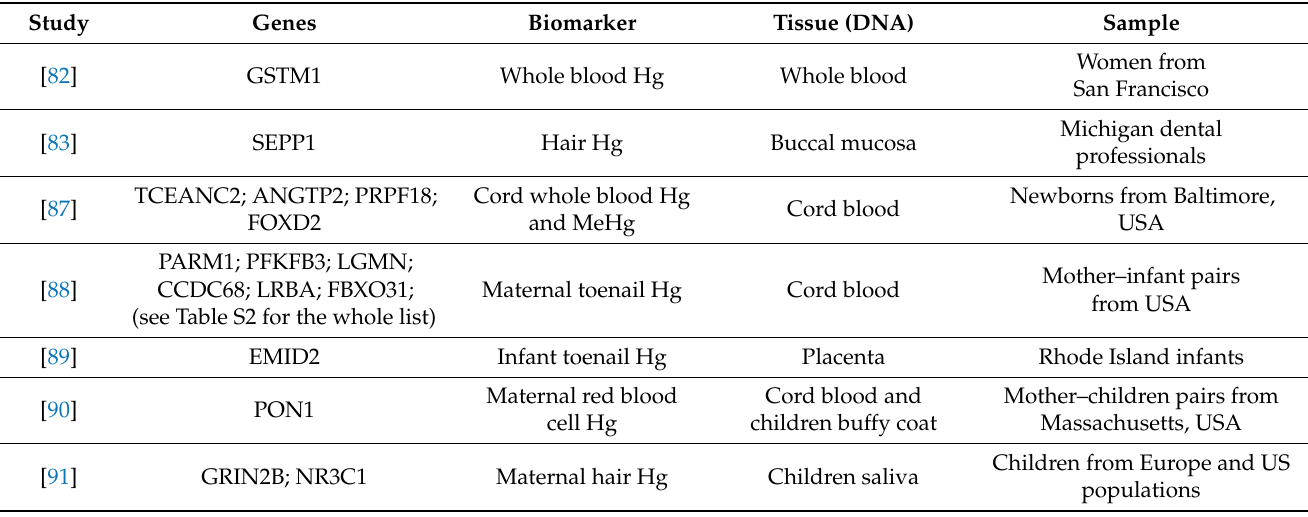
Table 3. List of epidemiological studies investigating the impact of MeHg exposure on DNA methylation. Genes in which the differentially methylated CpG dinucleotides were identified, biomarkers measured, tissues from which DNA was extracted, and samples studied are shown for each study.